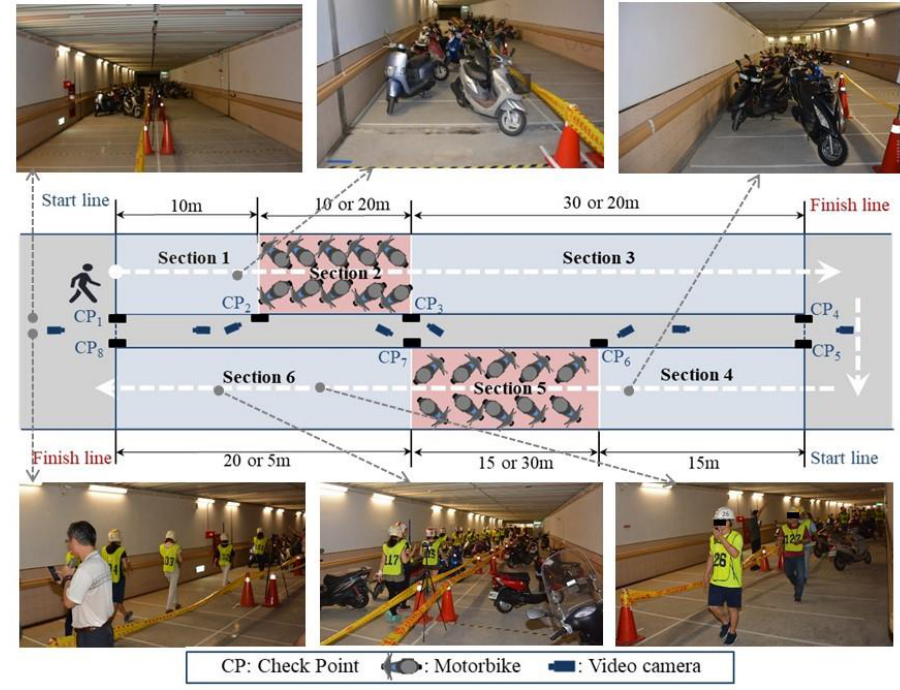
Figure 4. Schematic of motorbike lane experiments.